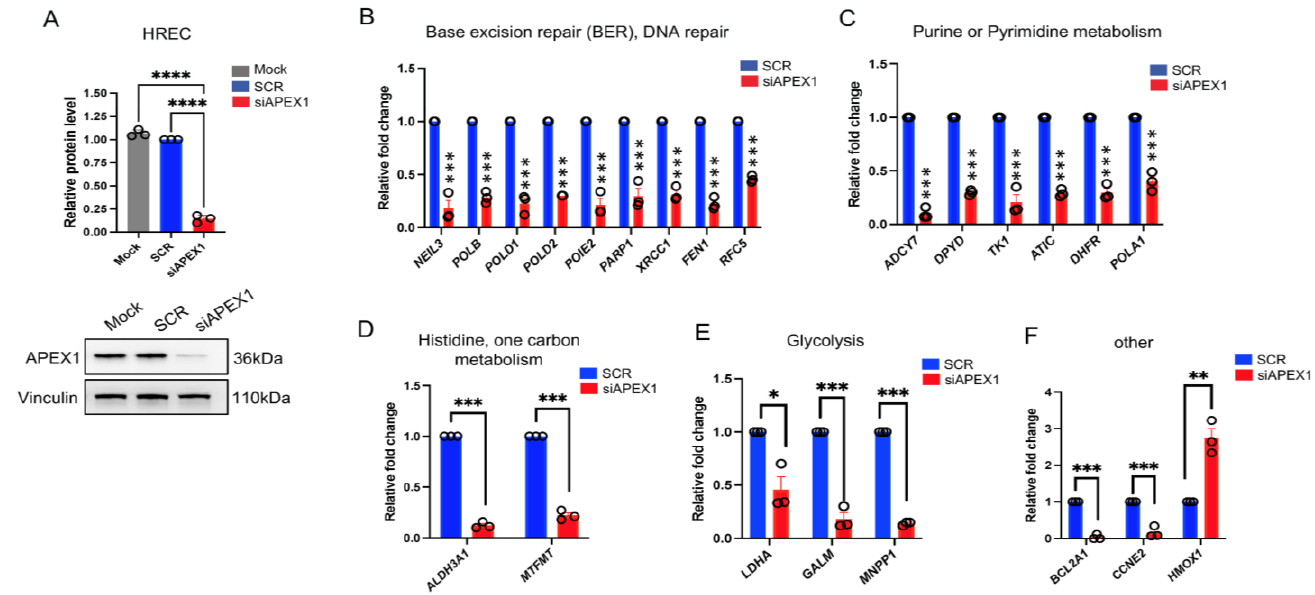
Figure 3. Validation of expression changes of selected genes from RNA-seq upon APEX1 KD. HRECs were transfected with 25 nM APEX1 siRNA and scrambled (SCR) control for 48 h. ( A ) The knockdown (KD) efficiency (>80% vs. SCR) was then confirmed by immunoblot. Vinculin was used as loading control. One-way ANOVA, **** p < 0.0001. These samples were used for the qPCR target validation. ( B – F ) mRNA expression levels of gene panels associated with multiple signaling pathways were significantly downregulated by APEX1 KD. In particular, the gene panels in base excision repair and DNA repair pathways, purine or pyrimidine metabolism signaling, histidine/one carbon metabolism pathways, glycolysis, and other pathways were assessed by qRT-PCR (Figure 2B–F, respectively). * p < 0.05, ** p < 0.01, *** p < 0.001, Student’s t -test. Data expressed as mean ± SEM, n = 3.